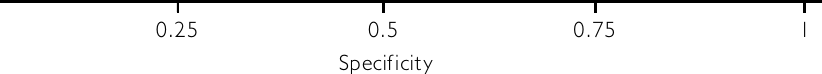
Figure 2 Receptor operative curve (ROC) for the pelvic inflammatory disease prediction model drawn up from being less than 20 years old, having purulent endocervical secretion, current use of intrauterine device and negative pregnancy